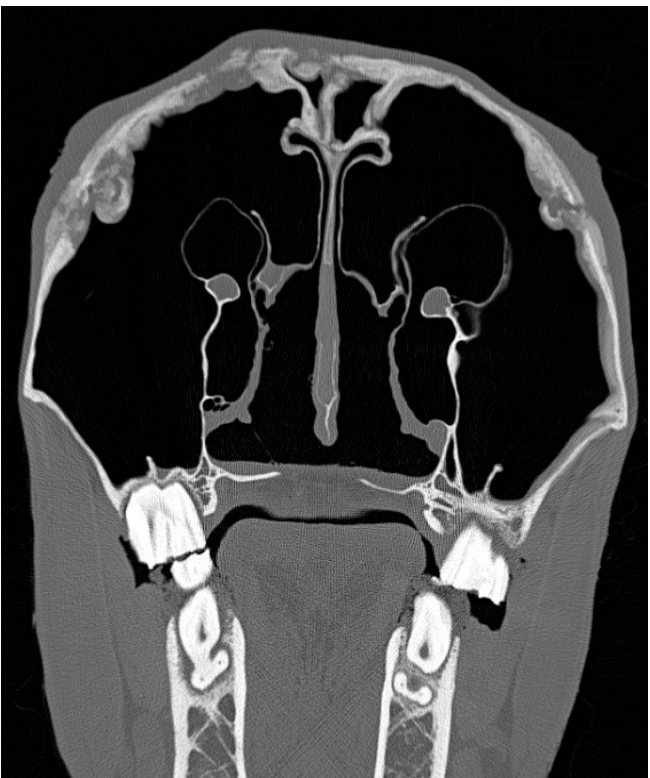
Figure 4. Transversal CT scan of a horse with bilateral idiopathic suture exostosis involving both nasolacrimal ducts. Reactions of sinus mucosa and skin are only mild.